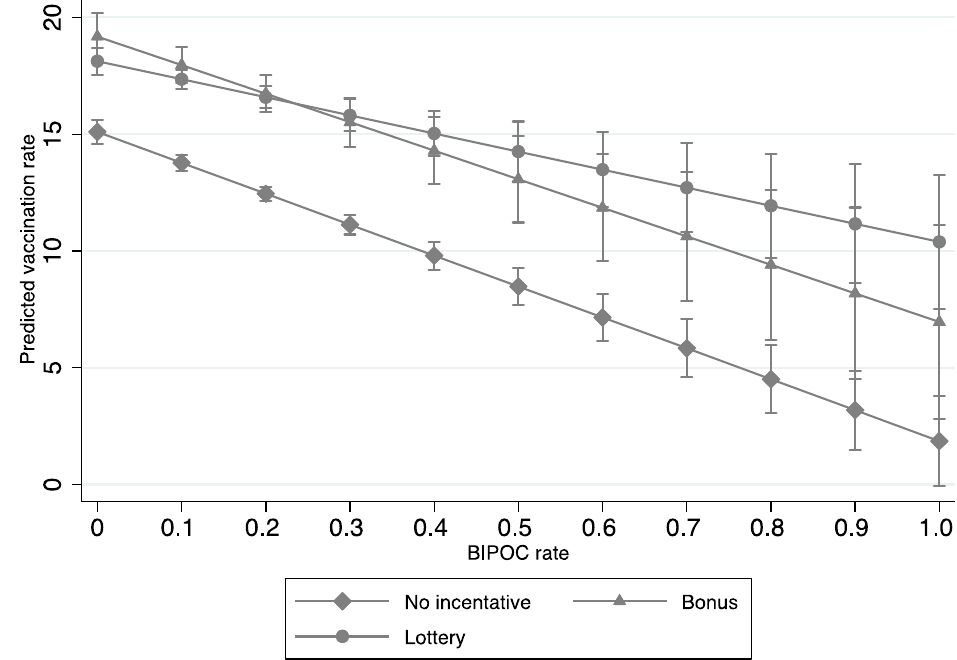
Figure 4. Interaction effects of COVID-19 vaccination incentive policies and rates of BIPOC (Model 6 in Table 3).